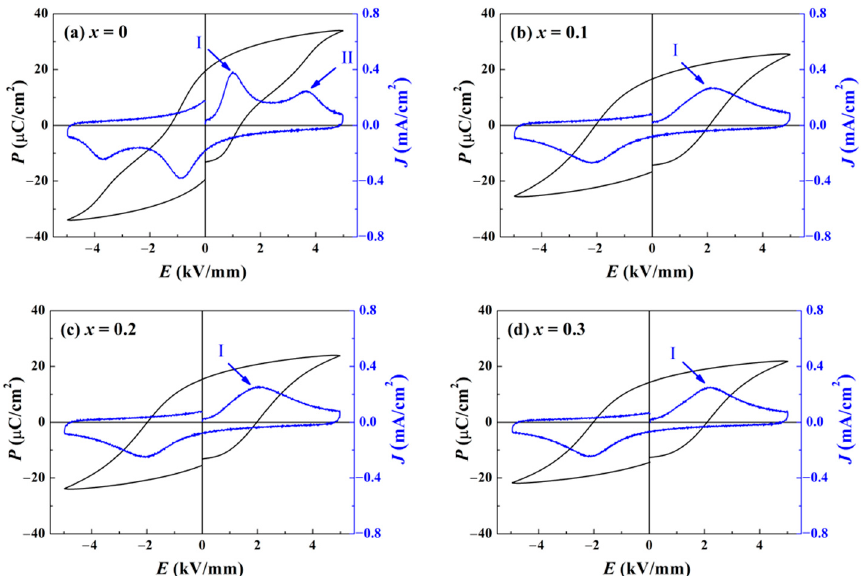
Figure 6. Polarization P versus electric field E hysteresis curve for BNKT-BT- x ZnO composites: ( a )